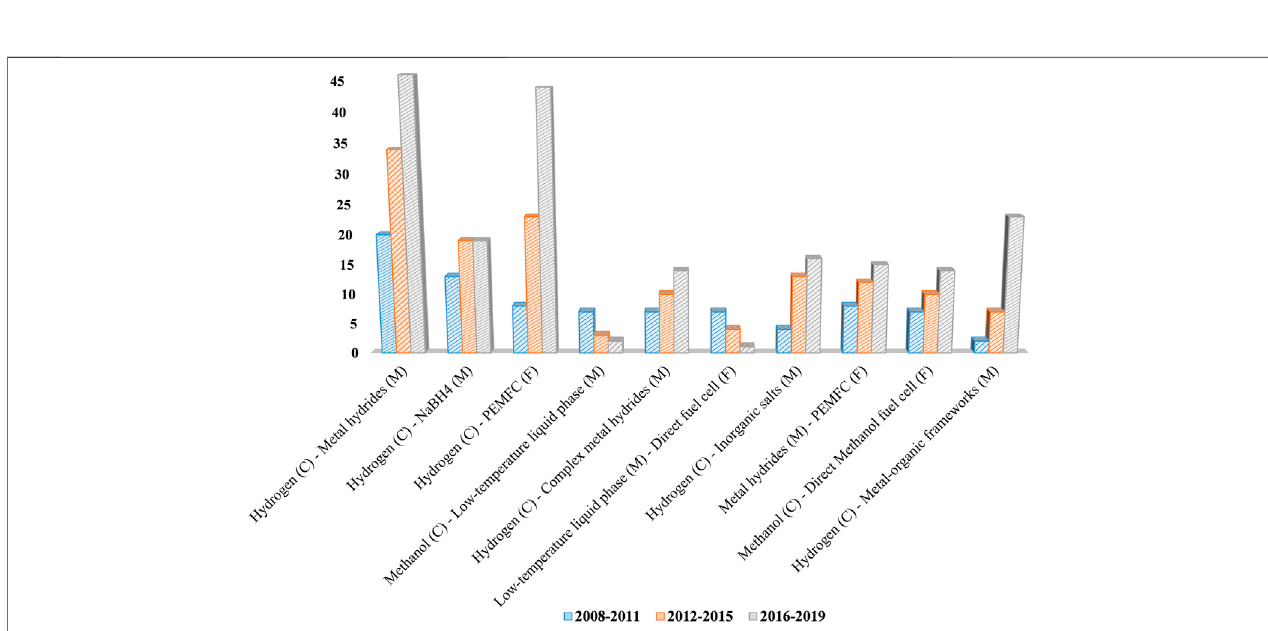
FIGURE 11 | The top 10 entity pairs.